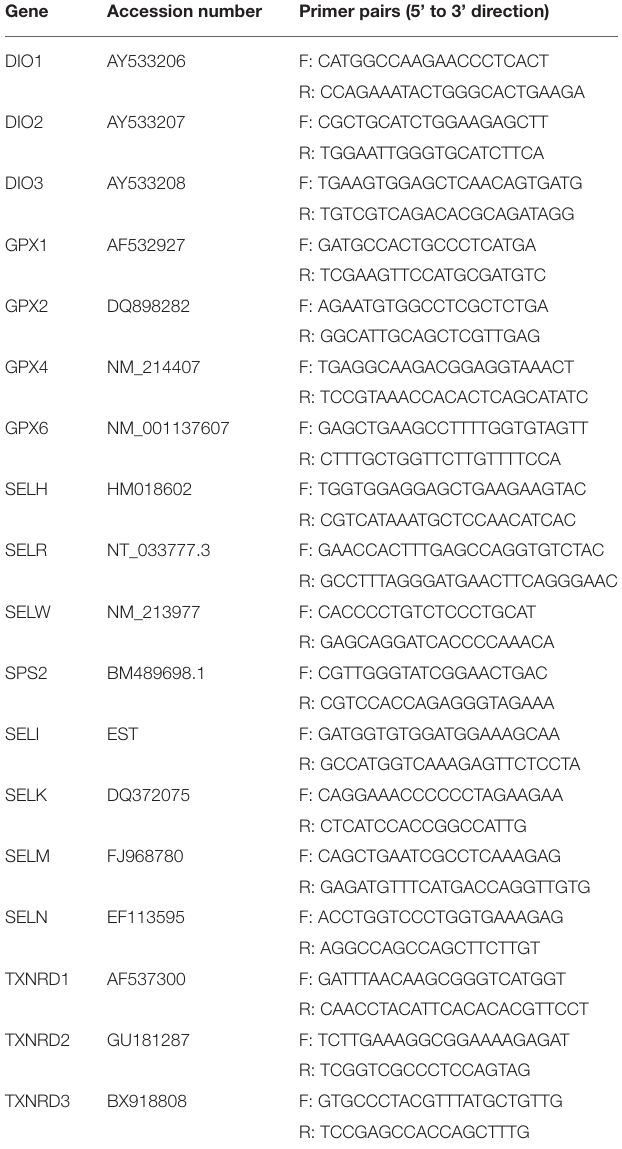
TABLE 1 | Primers used for